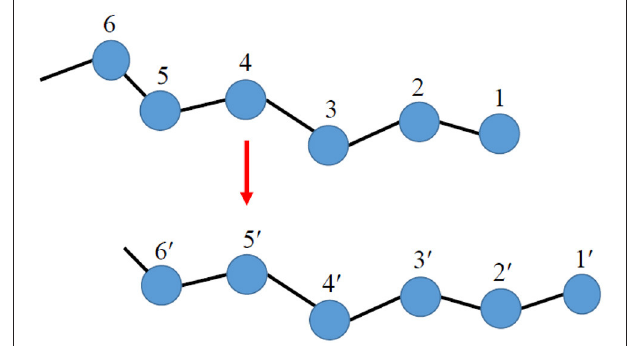
FIGURE 1 | Schematic illustration of the reptation (slithering-snake) Monte Carlo move for polymer simulations in continuous space.